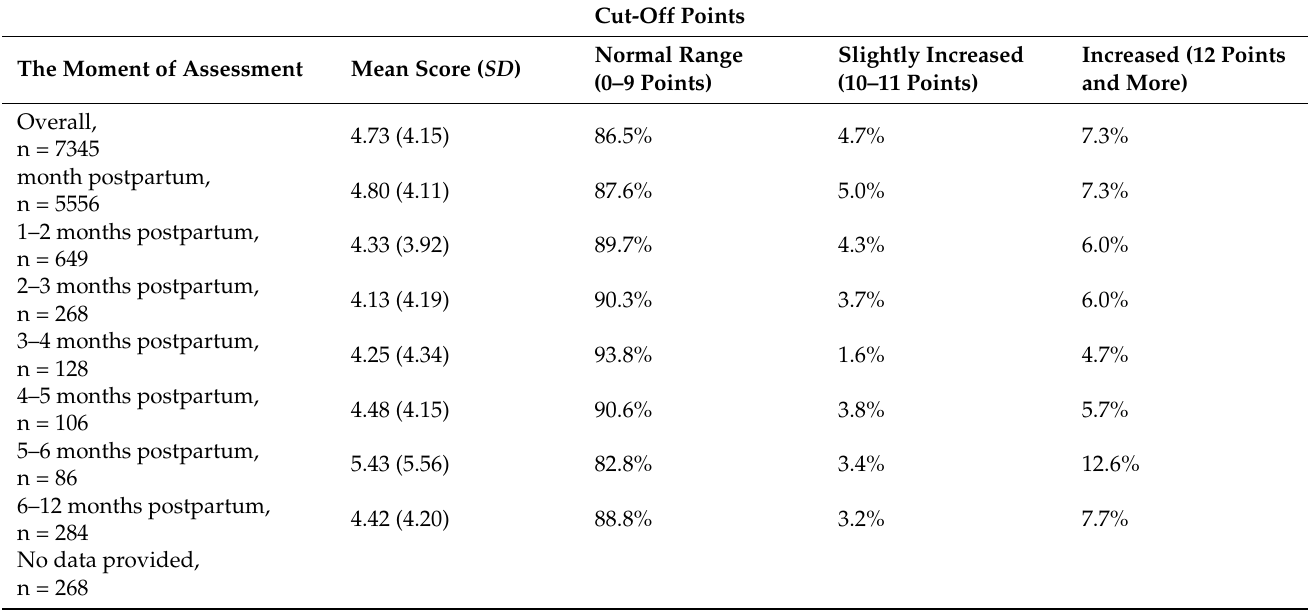
Table 1. Occurrence of the scores obtained by postpartum women in direct screening for PPD with EPDS (regarding the cut-off points) in the ‘Next Stop: Mum’ project, n =